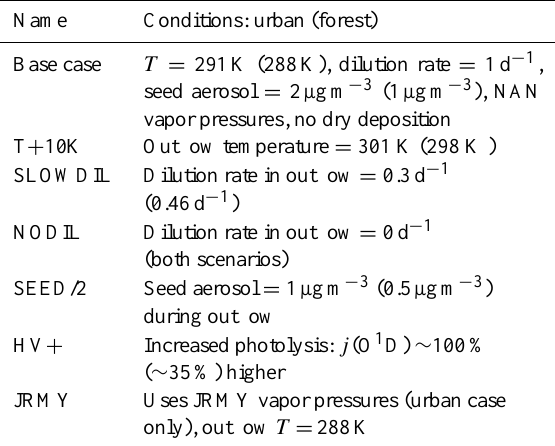
Table 1. List of sensitivity